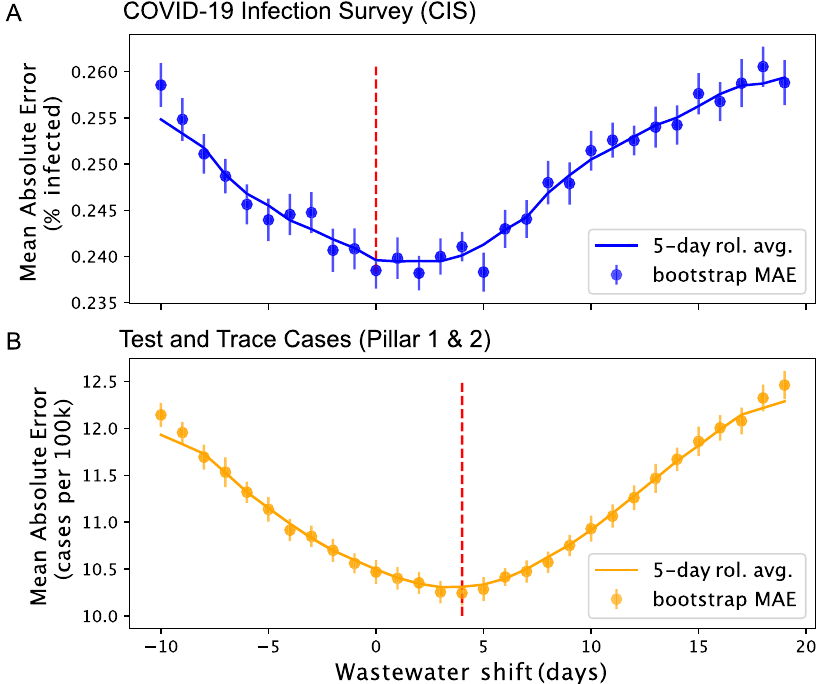
Fig. 5 Lead and lag analysis of the WW data when compared to (A) CIS and (B) Test and Trace cases. The shift (in days) associated with the minimal error is indicated by the red dotted line. A minimal error reached for a positive number of WW shifted days can be interpreted as a lead from wastewater by as many days. No clear lead of WW over CIS has been observed in this analysis, but an approximate 4 days lead over T&T has been observed. Vertical bars indicate the 95% con fi dence intervals of the mean absolute error across